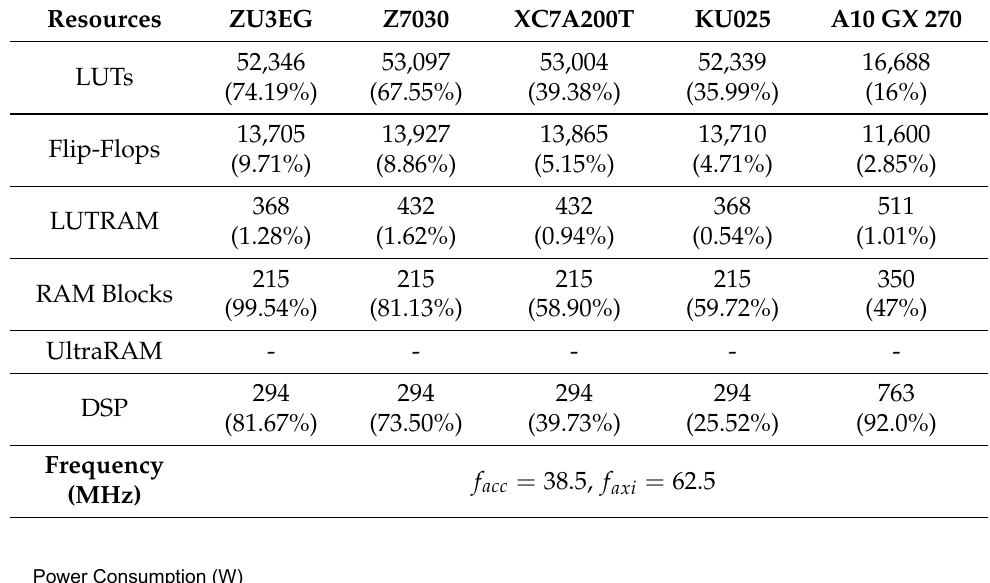
Table 5. System implementation on different FPGAs.